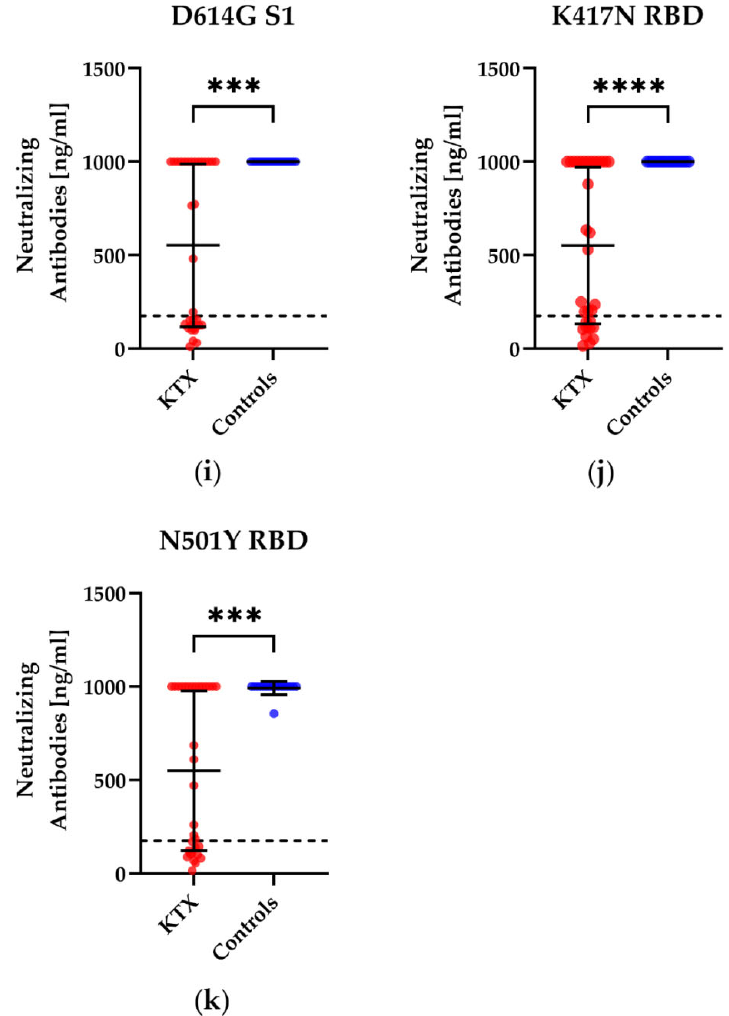
Figure 4. Concentration of potential neutralizing antibodies towards different variants of the subunit 1 of spike protein (S1) or the receptor-binding domain (RBD) of SARS-CoV-2 in kidney transplant (KTX) patients and healthy volunteers (controls) after booster vaccination. Humoral responses after booster vaccination against ( a ) wild type S1, ( b ) wild type RBD, ( c ) alpha S1, ( d ) beta S1, ( e ) gamma RBD, ( f ) E484K RBD, ( g ) epsilon RBD, ( h ) kappa RBD, ( i ) D614G S1, ( j ) K417N RBD and ( k ) N501Y RBD. The mutation D614G can be found in the delta and omicron variants, while K417N and N501Y are mutations in the omicron variant. Red circles show data of the KTX patients, while blue circles indicate the data of healthy volunteers. Two ‐ tailed Mann–Whitney tests were used to compare the responses (*** p < 0.001, **** p < 0.0001). Mean values are represented by horizontal lines, while the standard deviation is represented by error bars. The dashed line indicates the cut ‐ off. In addition, we measured the antibody ratio in 32 KTX patients and in 17 healthy controls. We detected a significantly lower antibody ratio in KTX patients compared to healthy volunteers (mean ratio of 3.7 vs. 9.3, p < 0.0001) (Figure 5). We observed no significant differences between 24 KTX patients after the third vaccination and eight KTX patients after the fourth vaccination ( p = 0.7).